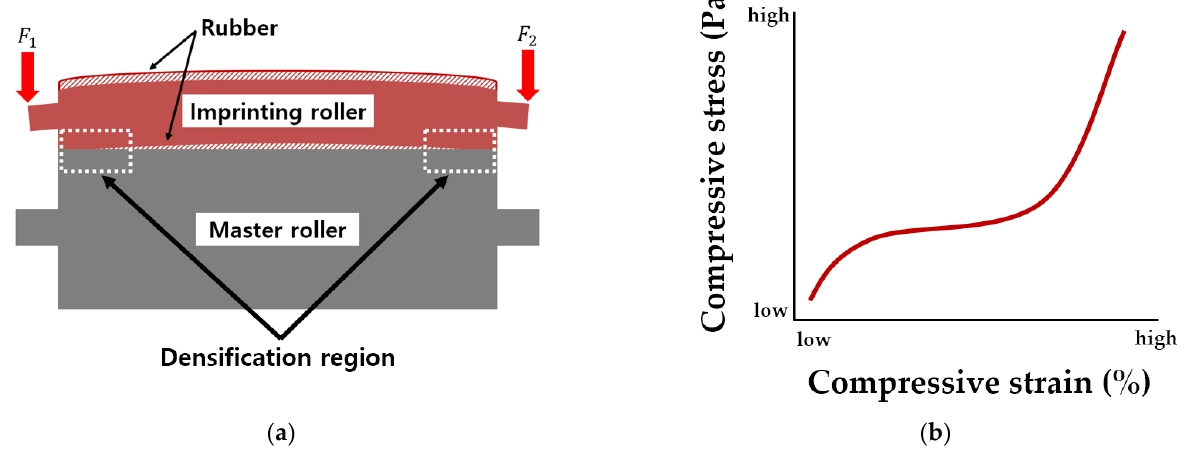
Figure 2. ( a ) Roller bending deformation of imprinting roller when pushing against master roller; the master roller’s deformation is ignored, and the imprinting roller has rubber skin. ( b ) The curve of the compressive measure for rubber.